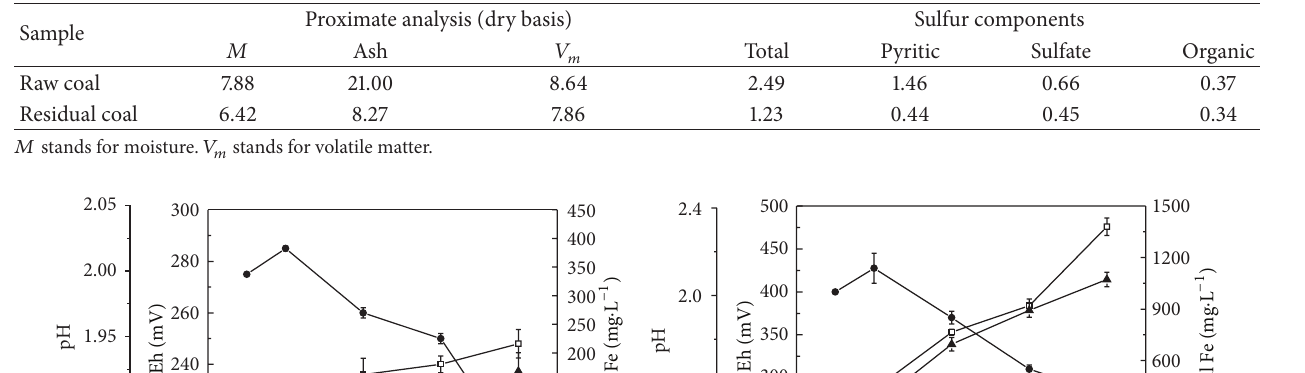
Table 1: Characteristics of the coal samples (wt%).